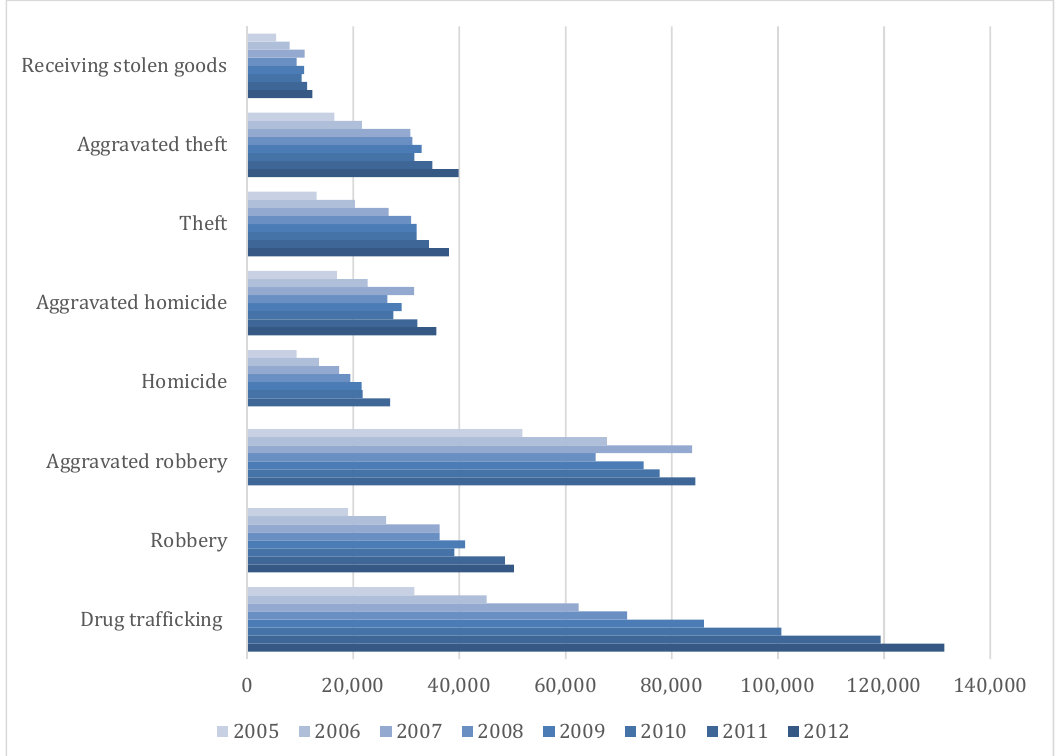
Figure 6: Number prisoners by type of crime in Brazil (for crimes with high incarceration rates), 2005 ‐ 2012 Source: DEPEN